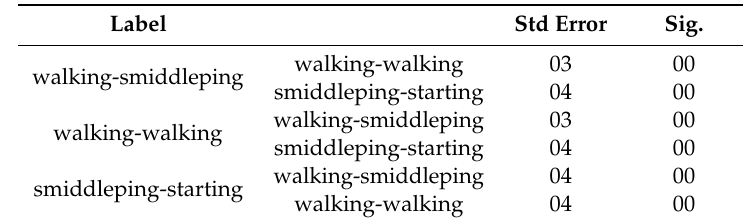
Table 8. Post-hoc comparison table.